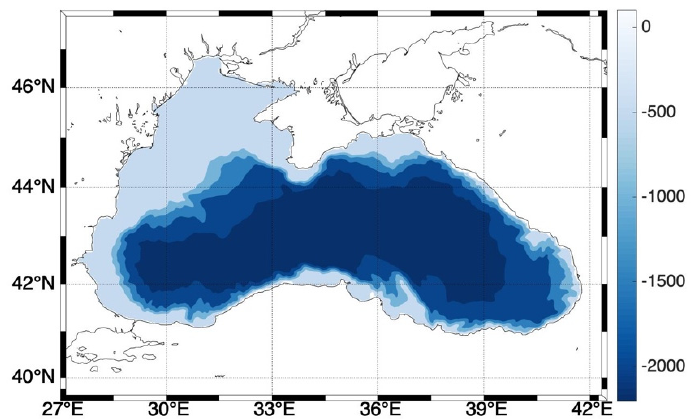
Figure 1. BSFS spatial domain and bathymetry (expressed in meters, from 0 to − 2200 m).